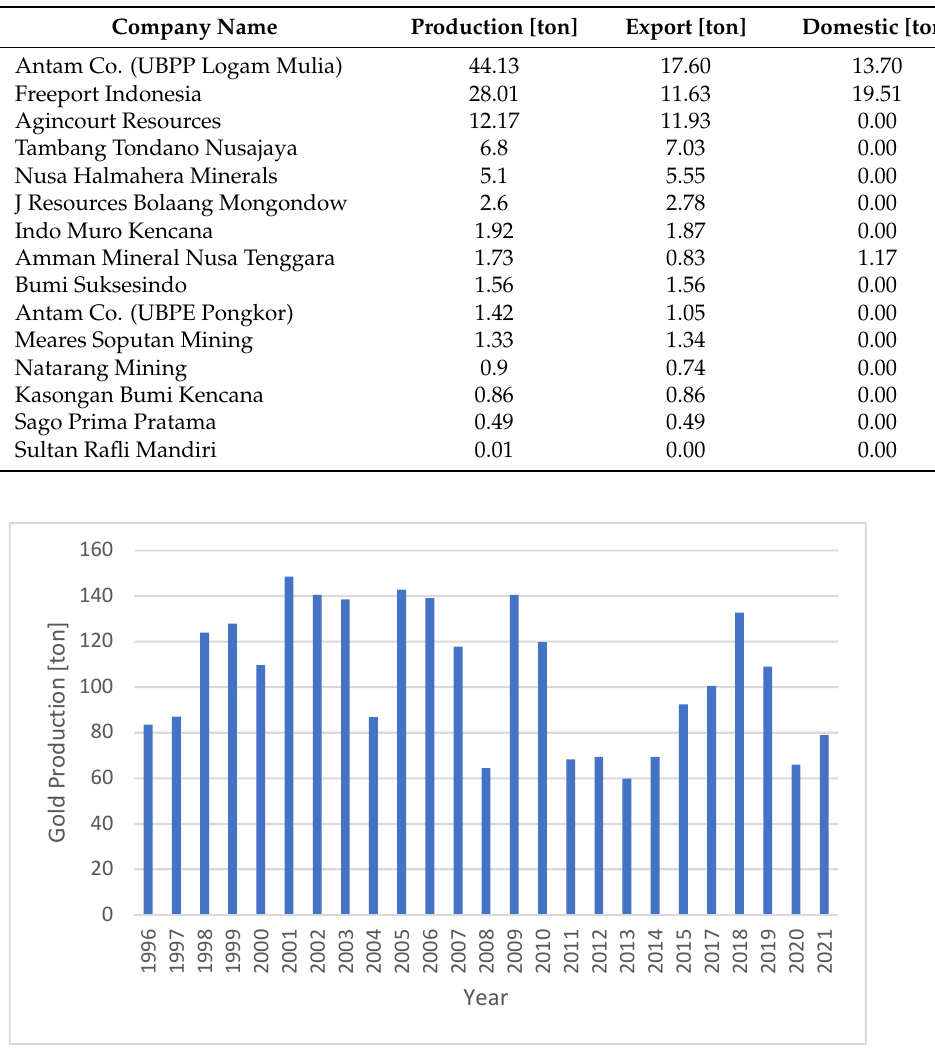
Figure 3. Gold production in Indonesia (Source: Ministry of Energy and Mineral Resources).